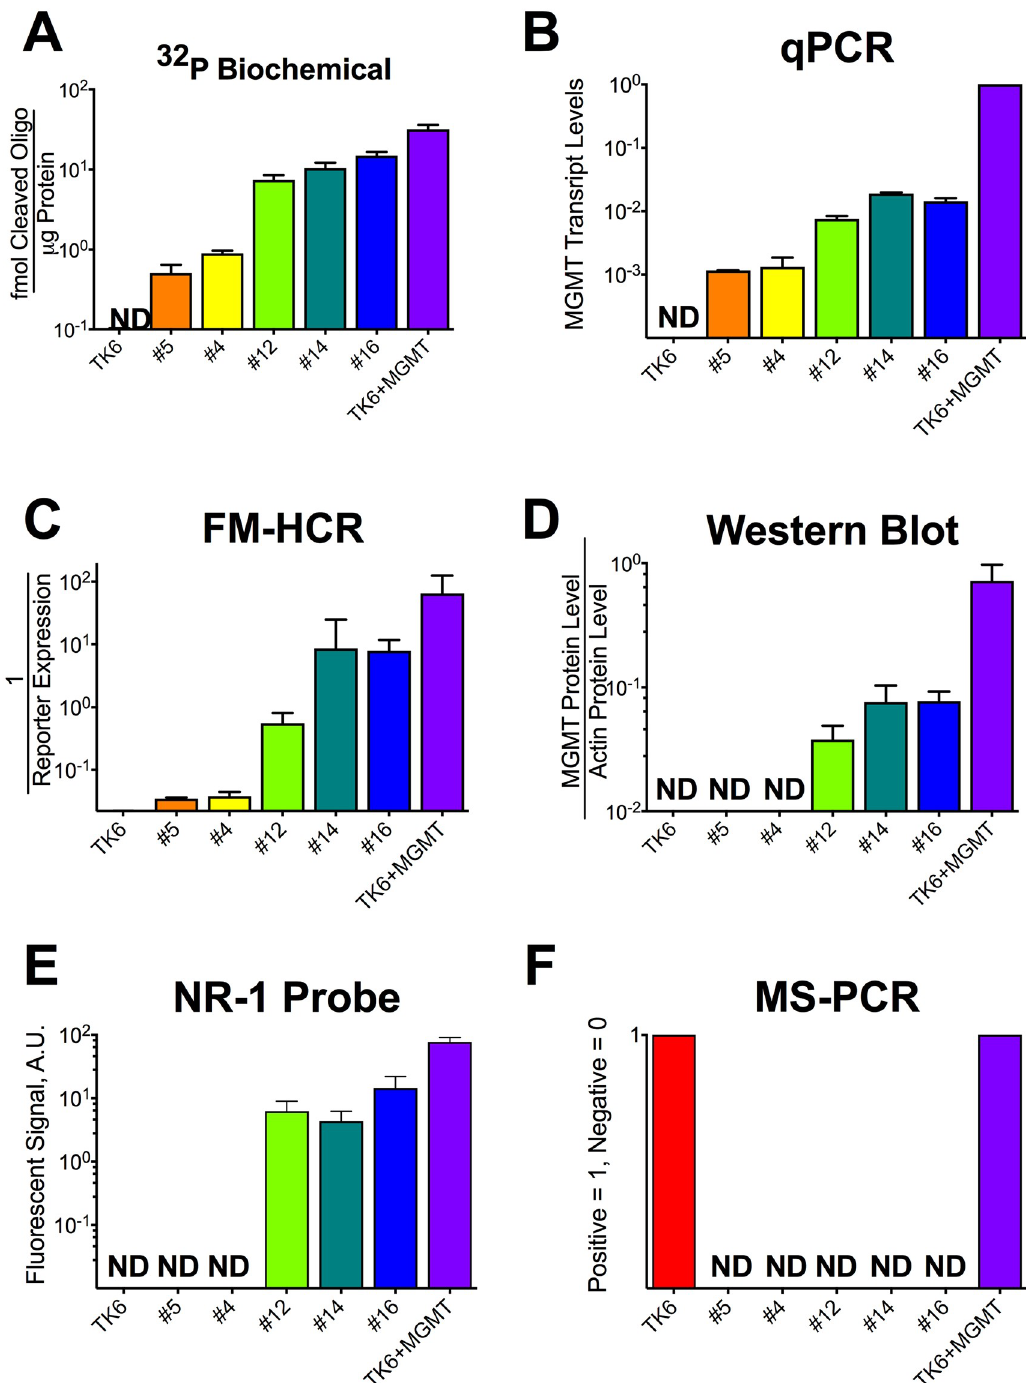
Fig 1. MGMT activity measured by 6 methods in 7 cell lines. A) MGMT activity reported as femtomoles of cleaved 32 P labeled O 6 -MeG containing oligonucleotide per microgram of protein in cell lysates. B) MGMT transcript levels normalized to TK6 +MGMT. C) MGMT activity measured by FM-HCR, reported as the inverse of reporter expression. D) MGMT protein levels in cell lysates measured by quantitative western blotting and normalized to GAPDH protein levels. E) MGMT activity in cell lysates measured using the NR-1 fluorescent probe and reported in arbitrary units of fluorescence. F) Results of methylation specific PCR assays for MGMT promoter methylation; a value of 1 was assigned to the three cell lines in which promoter methylation was detected. Cell lines were ranked in ascending order of MGMT activity measured by the biochemical assay in panel A; the order and color scheme is preserved in each panel. Error bars represent the standard deviation of at least 3 measurements, and